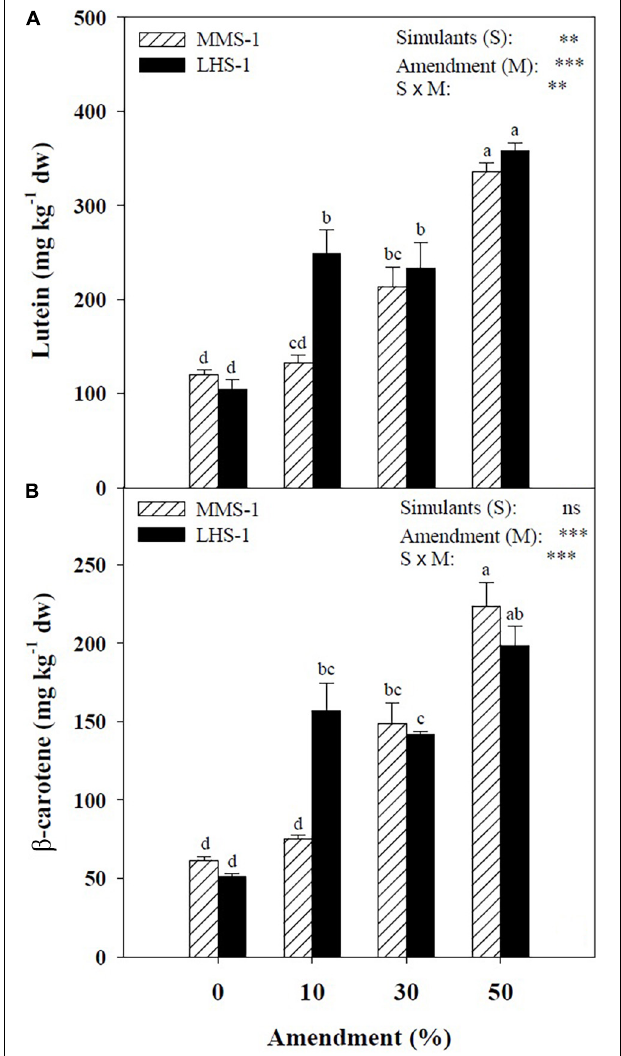
FIGURE 2 | Lutein and β -carotene concentration of lettuce grown in different mixtures of MMS-1 or LHS-1 simulants and manure (simulant/manure rates: 100:0, 90:10, 70:30, 50:50;